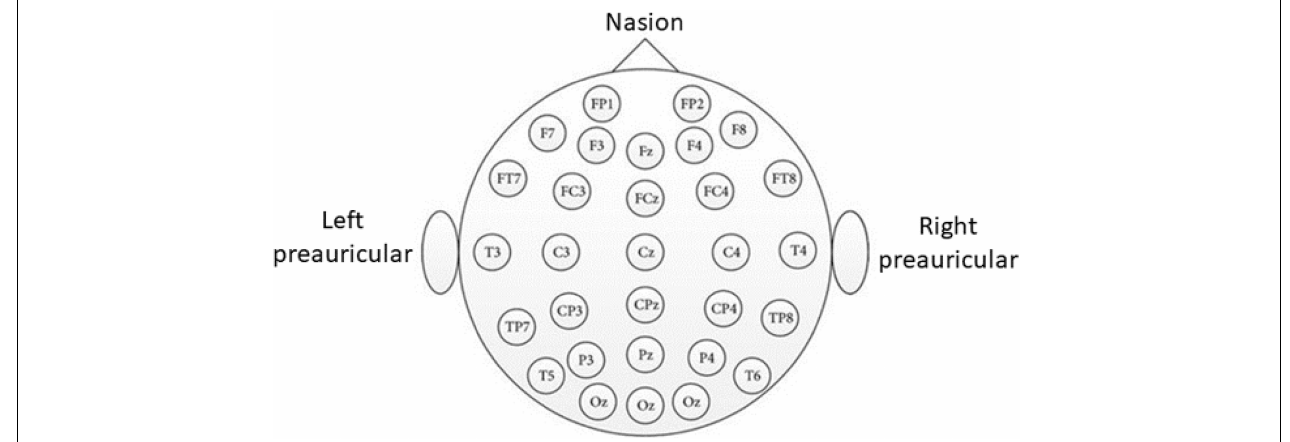
FIGURE 2 | The 10–20 international system used for EEG channel location. (1) Distances between adjacent electrodes being 10 or 20% of the total front-back or left to right distance along the skull, (2) Each site is named a letter and a number, (3) Letters F, T, C, P, and O identify the Frontal, Central, Parietal, and Occipital lobes, respectively, (4) The numbers identify the location along the hemisphere where even numbers are to the right and odd numbers are to the left, and (5) the letter Z identifies the electrode placed on the